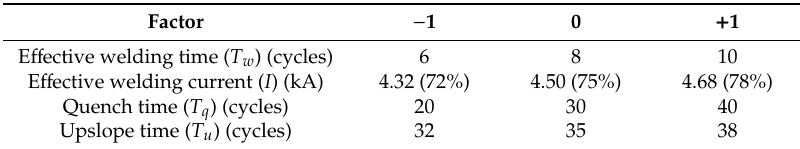
Table 11. Factor levels for the face centered